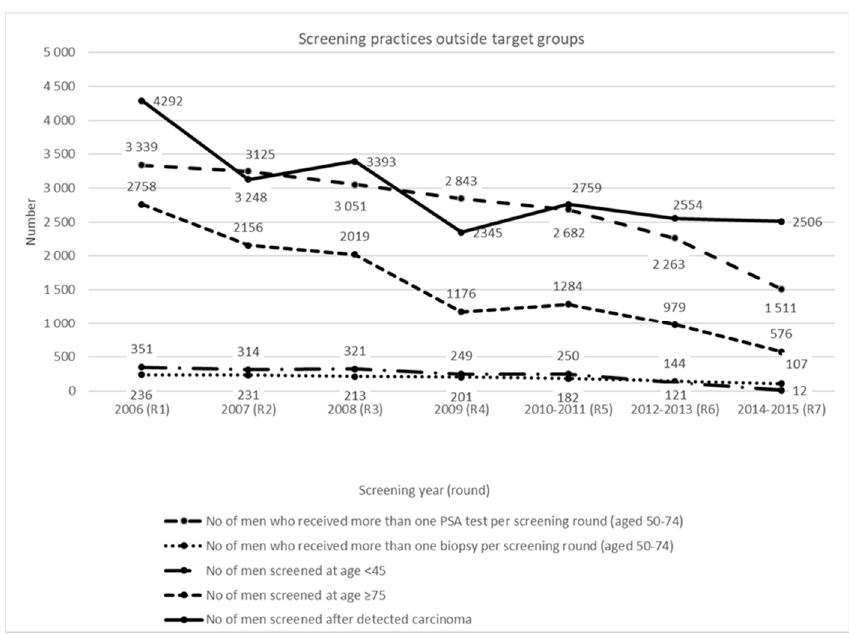
Figure 3. Screening practices outside the target population in the first seven screening rounds (2006– 2015).